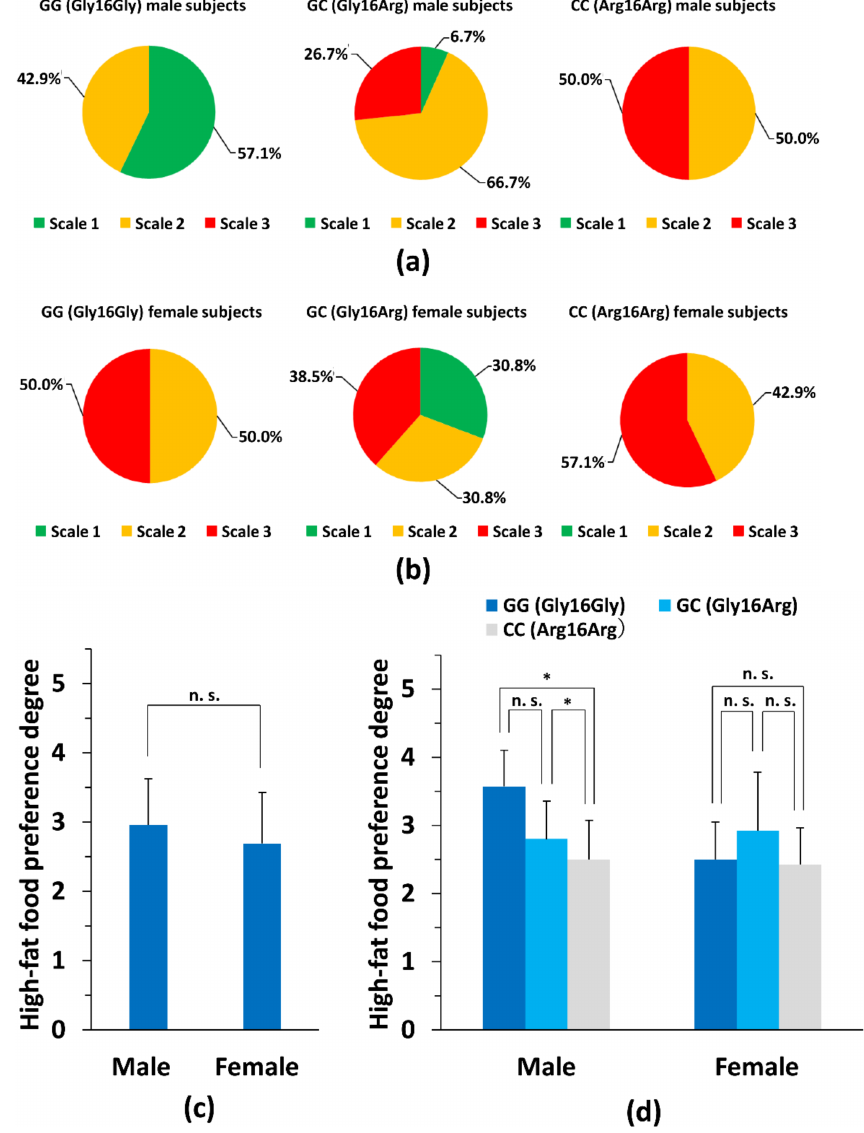
Figure 4. Comparison of greasy food preference degrees among genotype subgroups in male and female subjects. In the self-reporting questionnaire for preference of taste, participants rated their preference